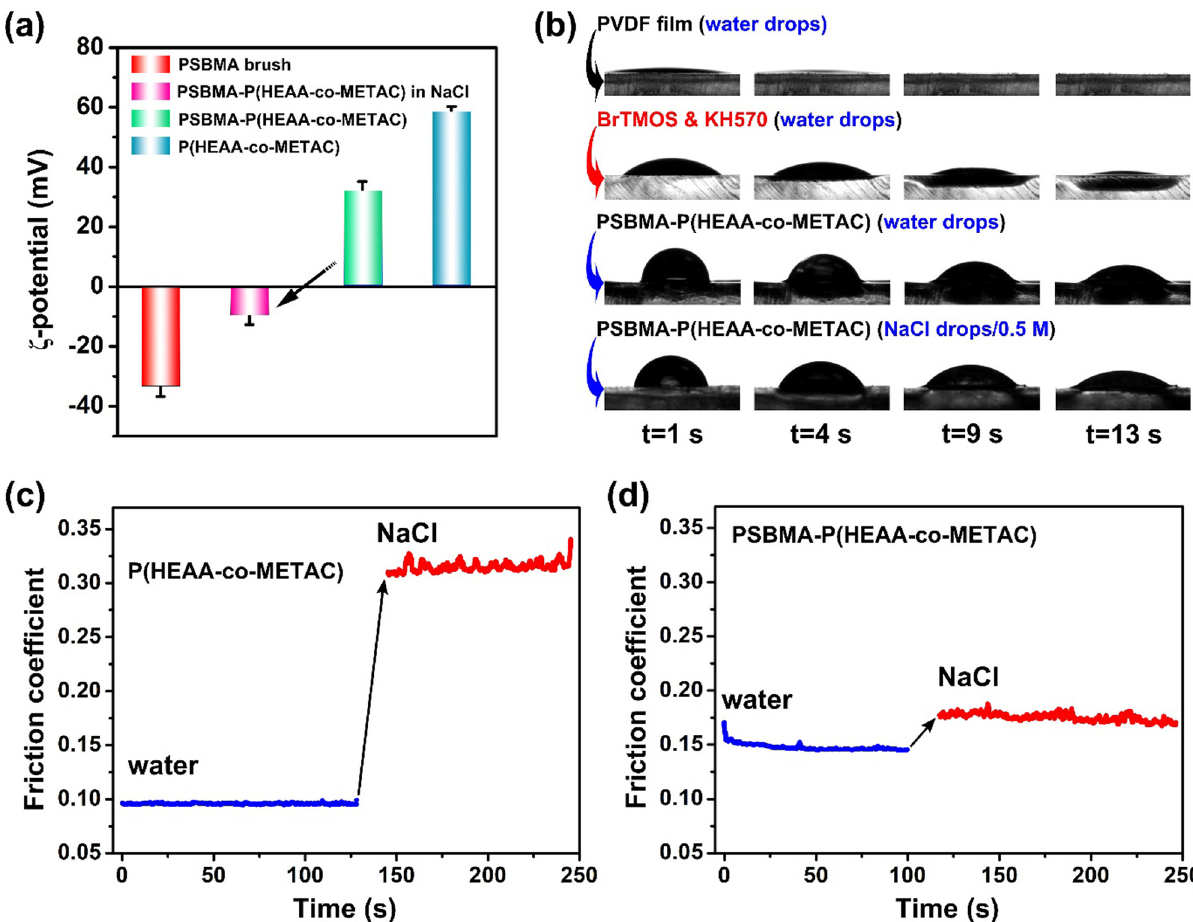
Figure 4: ( a ) ζ - Potentials of the PSBMA brushes, P ( HEAA - co - METAC ) , and the PSBMA - P ( HEAA - co - METAC ) surfaces. ( b ) The comparison of the contact angle change among di ff erent surfaces. Surface friction of ( c ) P ( HEAA - co - METAC ) hydrogel and ( d ) PSBMA - P ( HEAA - co - METAC ) hybrid coating in water and then switch to 0.5 M